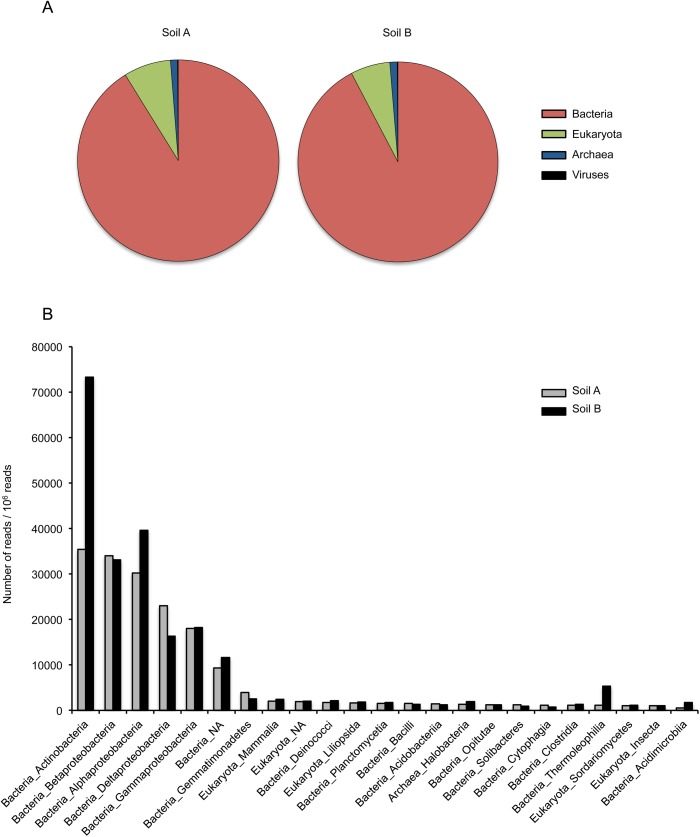
Metagenome data for control soils.(A) Proportion of DNA for Bacteria, Eukaryota, Archaea, and viruses detected in a random subset of 106 reads from each soil sample. Only DNA reads that display an E-value lower than 0.01 for BLAST alignment to the nt/nr database were considered. This corresponds to 19.0 and 23.7% of all reads for soils A and B, respectively. In soil A, Bacteria, Eukaryota, Archaea, and viruses correspond to 91.2%, 7.6%, 1.1% and 0.1% of assigned reads. In soil B, Bacteria, Eukaryota, Archaea, and viruses correspond to 92.3%, 6.4%, 1.2% and 0.1% of assigned reads. (B) Organism classes detected through a minimum of 1,000 DNA reads in at least one soil sample.